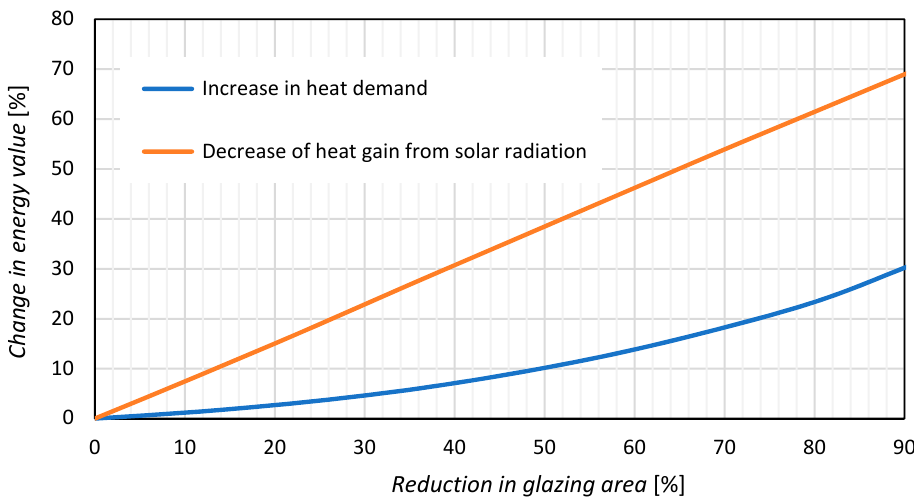
Figure 9. Influence of the glazing area of the southern windows on the heat gains and losses in the analyzed modular house.